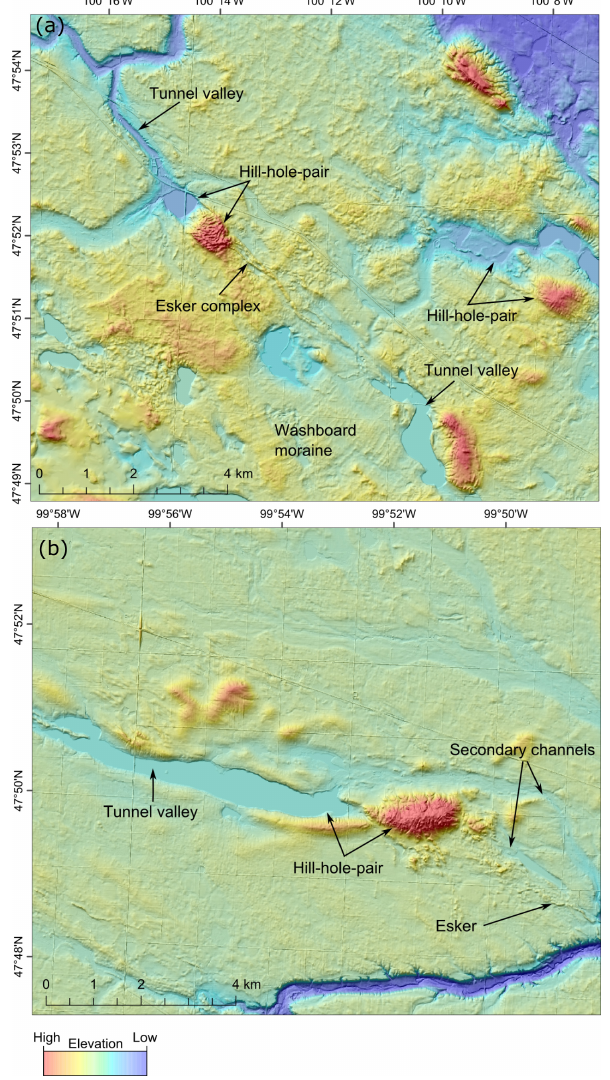
Figure 12. Hill-hole pairs in North Dakota and their association with tunnel valleys. (a) Note the esker downstream of the hill, which trends into an aligned tunnel valley segment. (b) Note the secondary meltwater channels and eskers that diverge around the hill.